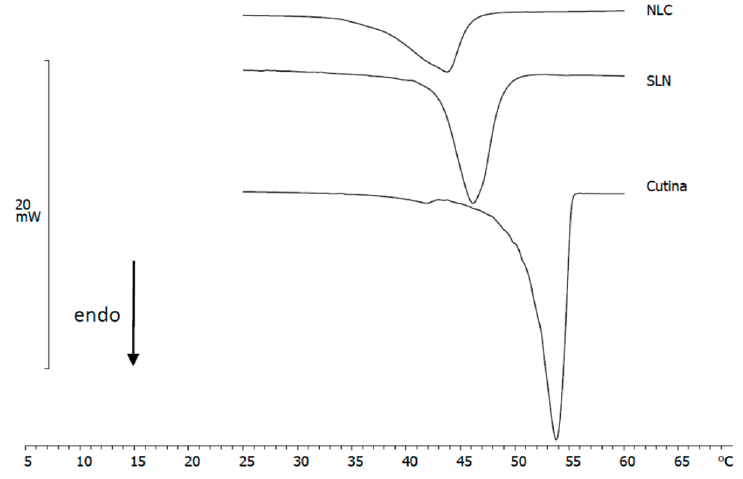
Figure 1. Calorimetric curves, in heating mode, of cutina, SLN, and NLC.